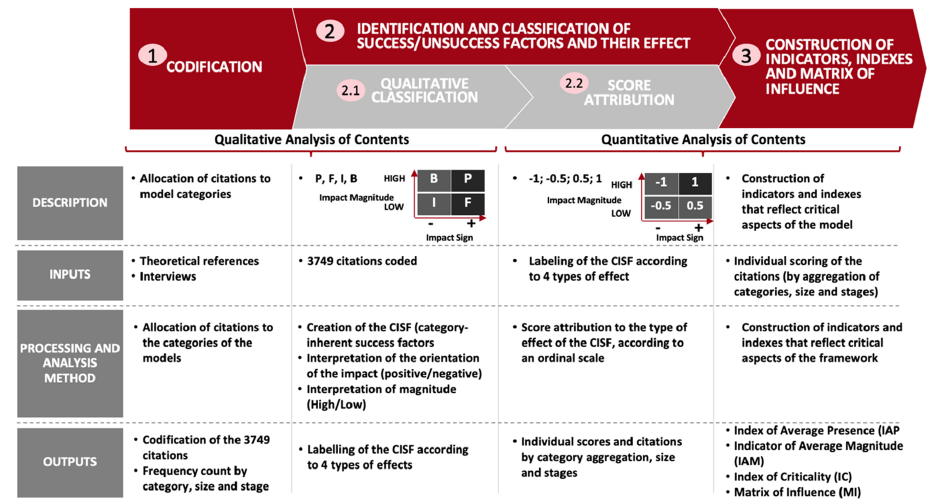
Figure 3. Steps adopted in the Quantitization of the Qualitative Data from Interviews. Source: the authors.